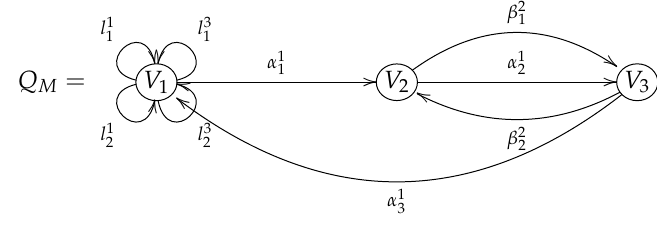
Figure 2. Brauer quiver induced by the Brauer configuration M